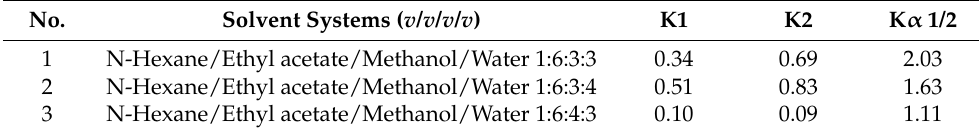
Table 1. K and K α values of target compounds 1 and 2 measured in the solvent systems tested. No.